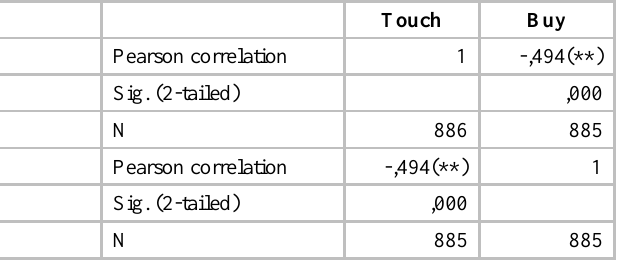
Table 4 . The relationship between approach and touch